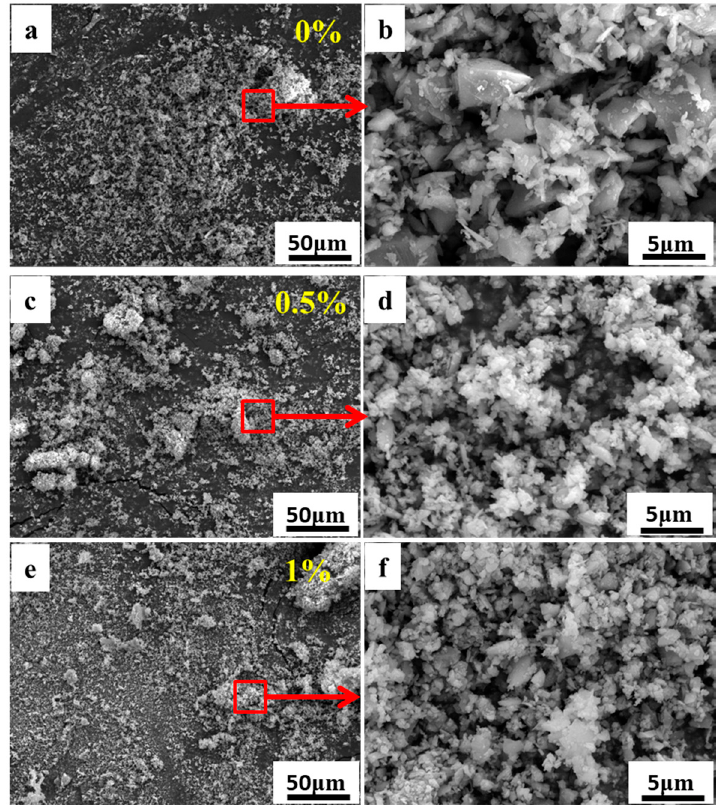
Figure 1. SEM images of SiC/PVB composite powders with different weight contents of the PVB binder. ( a , b ) for 0 wt. %; ( c , d ) for 0.5 wt. %; ( e , f ) for 1 wt. %.